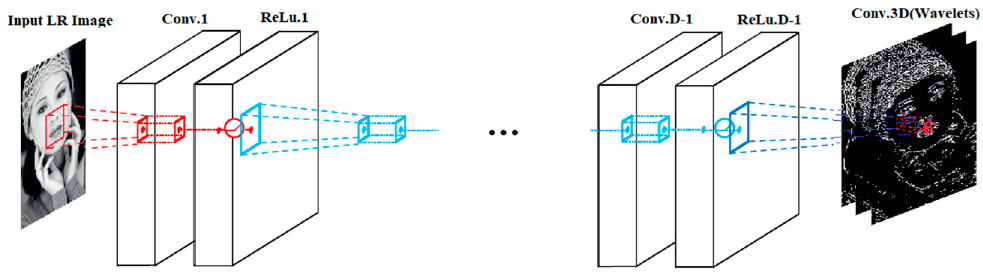
Figure 3. The wavelet deep network configuration.